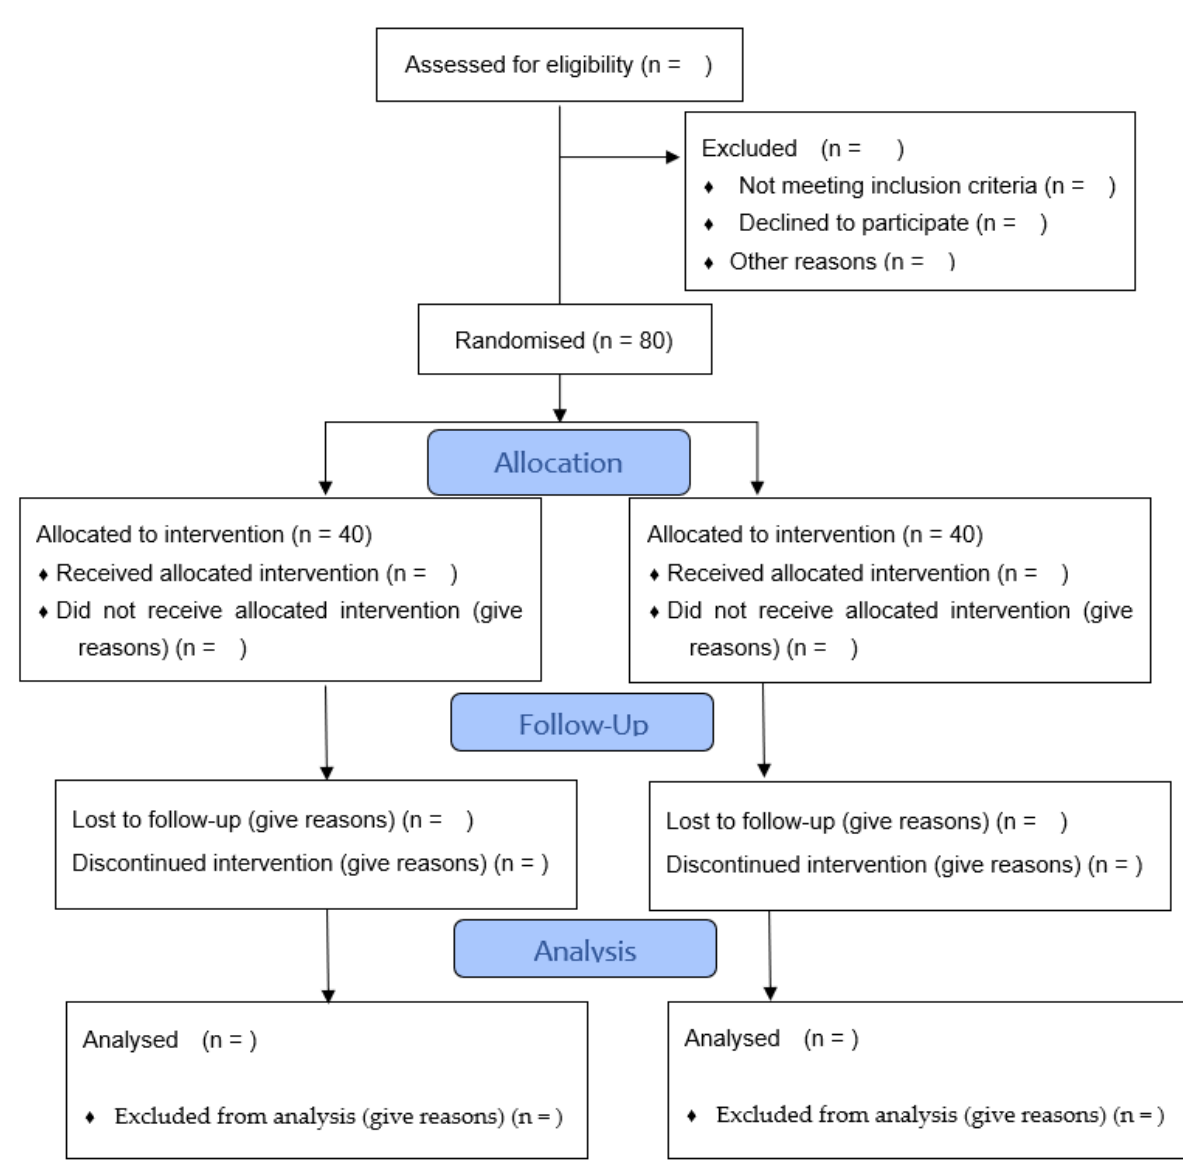
Figure 1. Flowchart of sample selection (obtained and modified from CONSORT 2010 Statement).